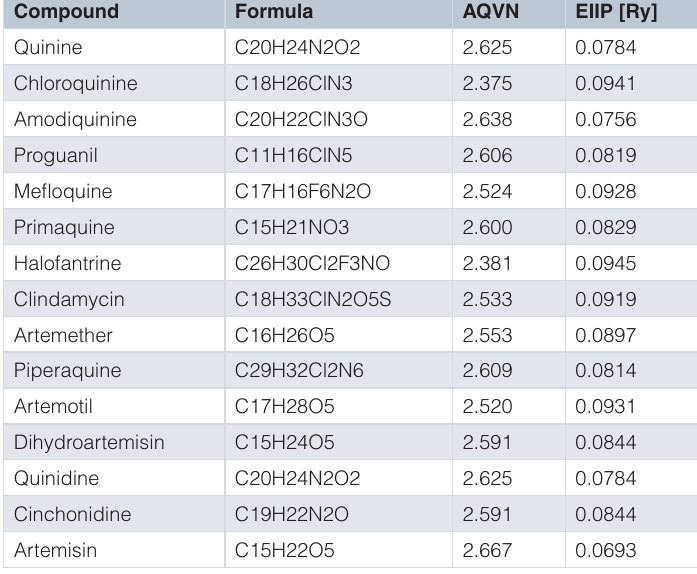
Table 3. Approved anti-malarial drugs selected as candidate drugs for